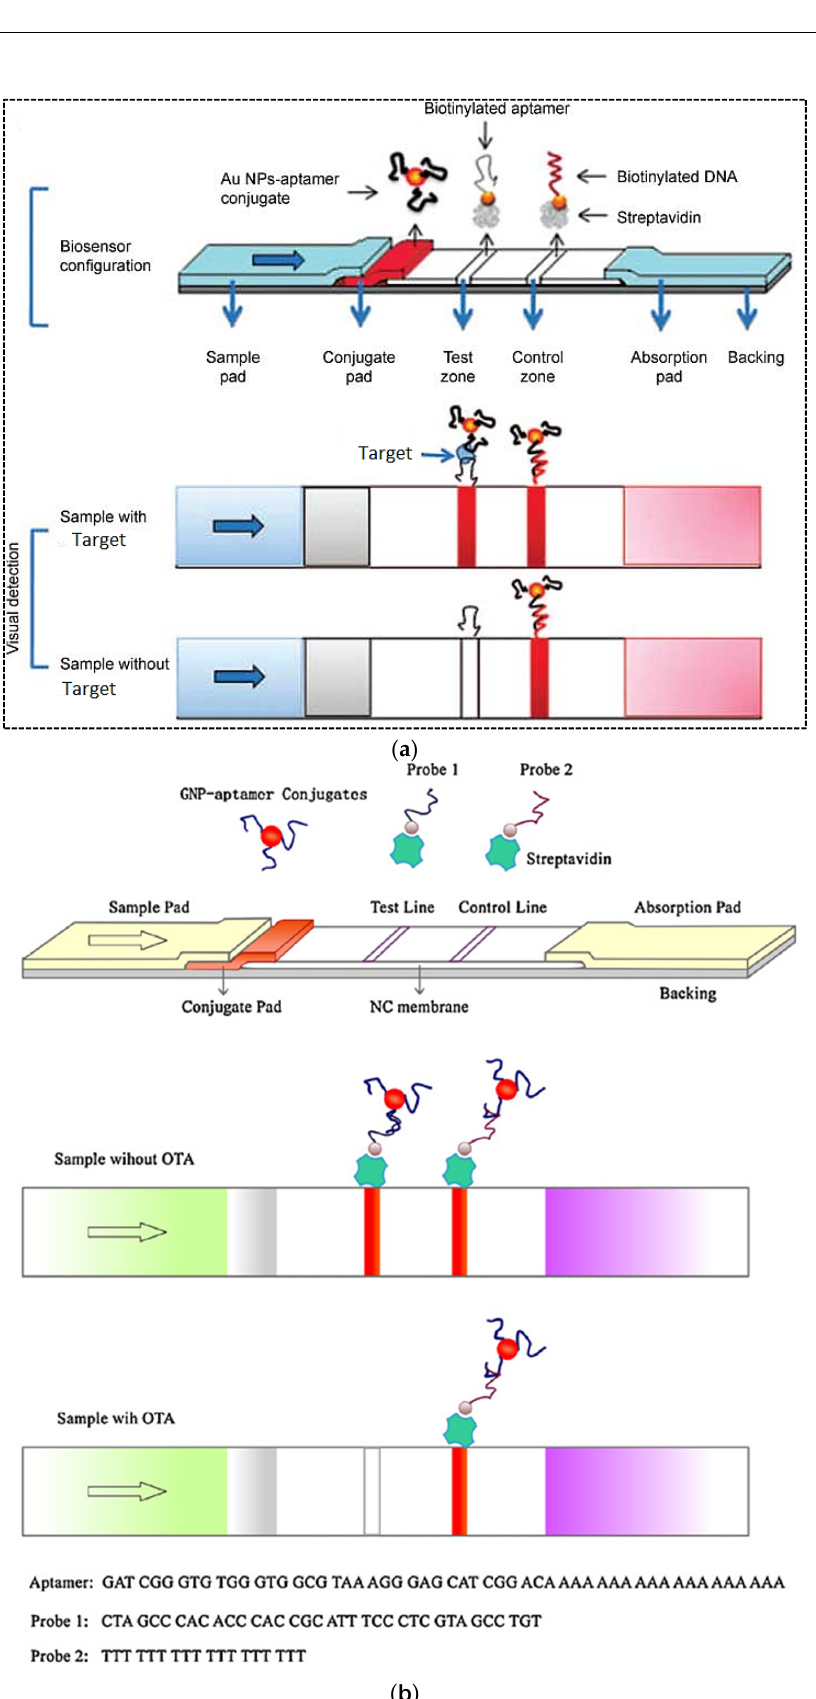
Figure 2. Principle of ( a ) sandwich aptamer-based LFA for the detection of thrombin; ( b ) competitive aptamer-based LFA for the detection of ochratoxin A. Reproduced with permission from [28,29],